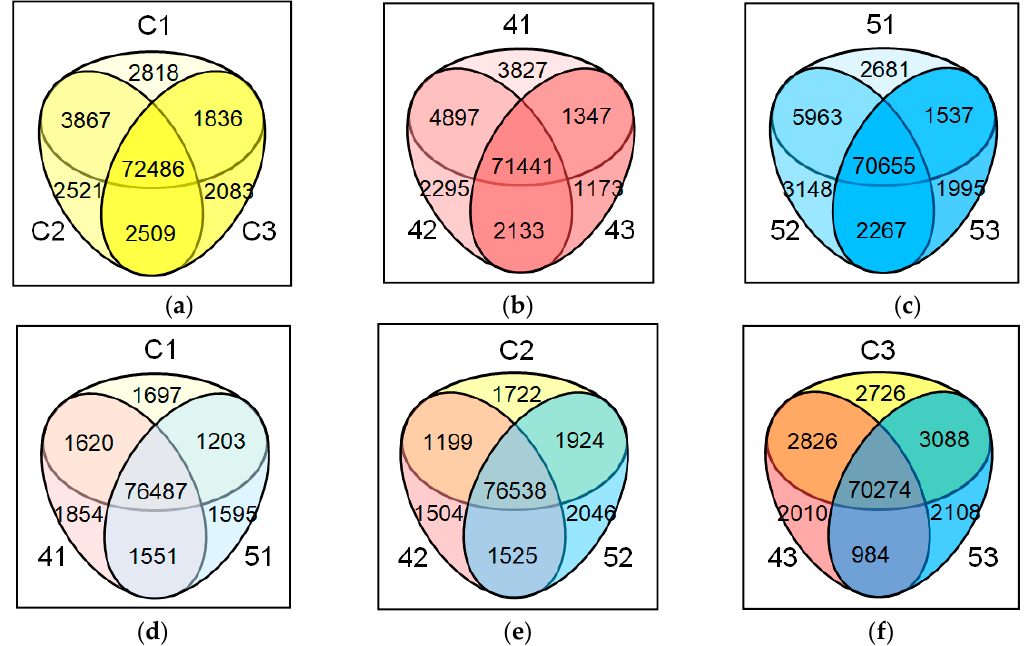
Figure 3. Venn diagrams for the expressed gene numbers showing overlapping yet distinct expression patterns depending on developmental stages or genotypes. ( a ) Youngsan at three different stages (8, 25, and 45 DAF): C1, C2, and C3. ( b ) CpFatB4 transgenic line at three different stages: 41, 42, and 43. ( c